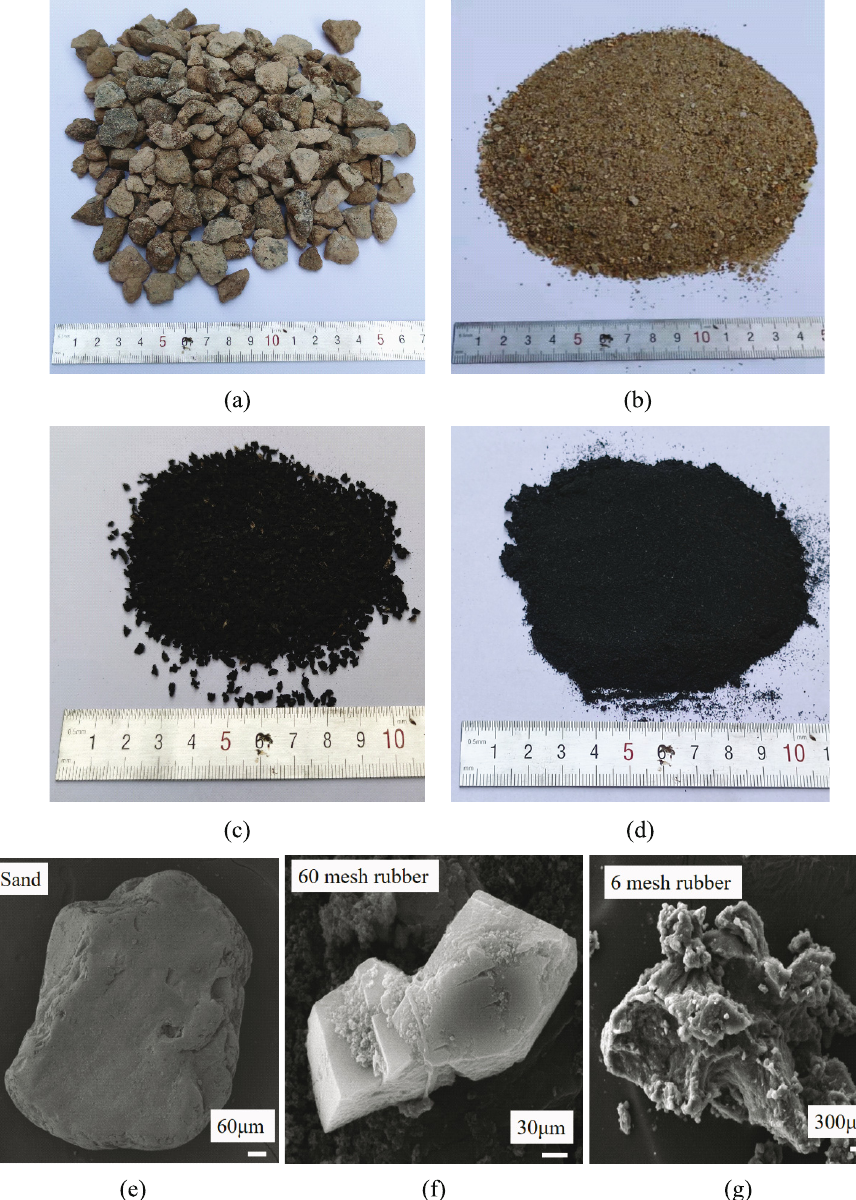
Figure 2: Aggregates used and their micromorphology as revealed by SEM. ( a ) RCA, ( b ) river sand ( c ) 6 mesh rubber, ( d ) 60 mesh rubber, (